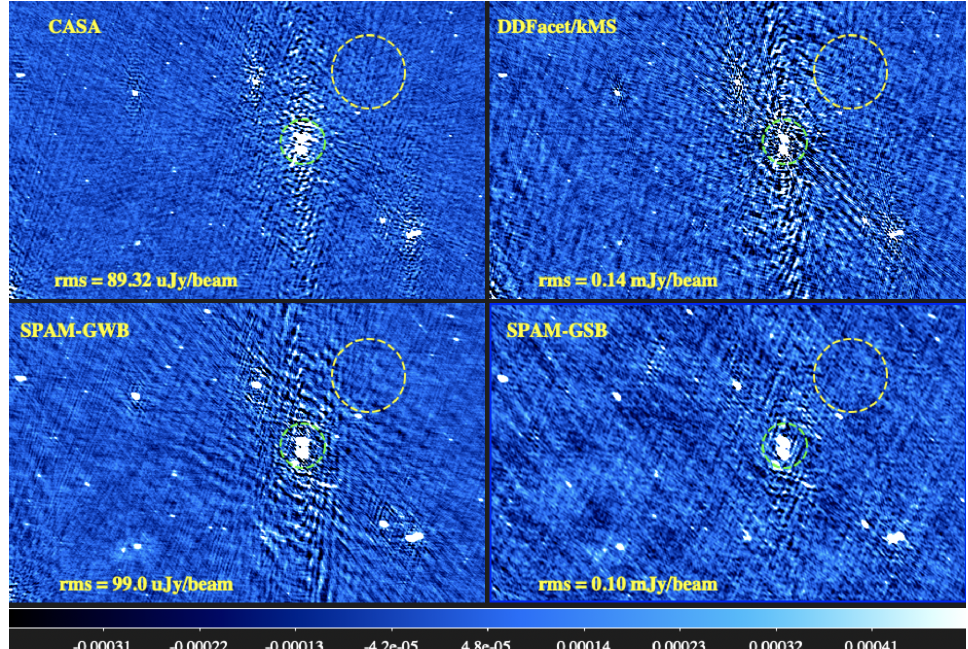
Figure 3. Gallery of GWB pipeline images of the J0034 field, which indicates the severity of the DDEs in our observations. The artefacts in all the frames are detected at 2 σ . The lower left panel shows the GSB image for comparison. In each panel, the green circle indicates the source used to measure peak brightness, and the yellow circle indicates the region, with the rms value indicated at the lower left. The angular radius of the noise region is 1.5 (cid:48) . The colour scale is the same for all panels. Top left : The CASA-pipeline reduced image (see Section 3.2.1). The beam size of the image is the beam size is (8.0 (cid:48)(cid:48) × 4.9 (cid:48)(cid:48) , p.a. 60.3 ◦ ). Top right : The DDFacet − killMS − pipeline reduced image (see Section 3.2.2). The beam size of the image is (7.9 (cid:48)(cid:48) × 4.5 (cid:48)(cid:48) , p.a. 52.4 ◦ ) Bottom left : Experimental wideband SPAM - pipeline reduced image (see Section 3.2.3). The beam size of the image is (14.0 (cid:48)(cid:48) × 7.6 (cid:48)(cid:48) , p.a. 65.3 ◦ ). Bottom right : The 325 MHz narrowband image produced using the standard SPAM pipeline. The beam size of the image is (18.1 (cid:48)(cid:48) × 14.2 (cid:48)(cid:48) , p.a. 48.2 ◦